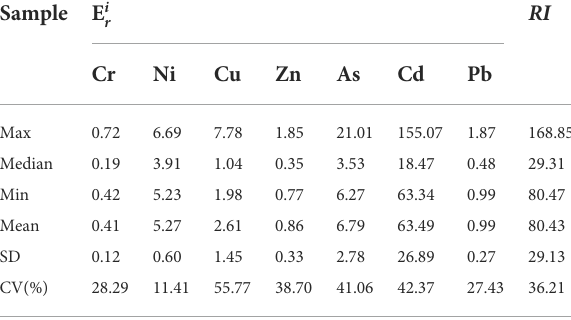
TABLE 7 The potential ecological risk index E i r and RI of different heavy metals. Sample E i